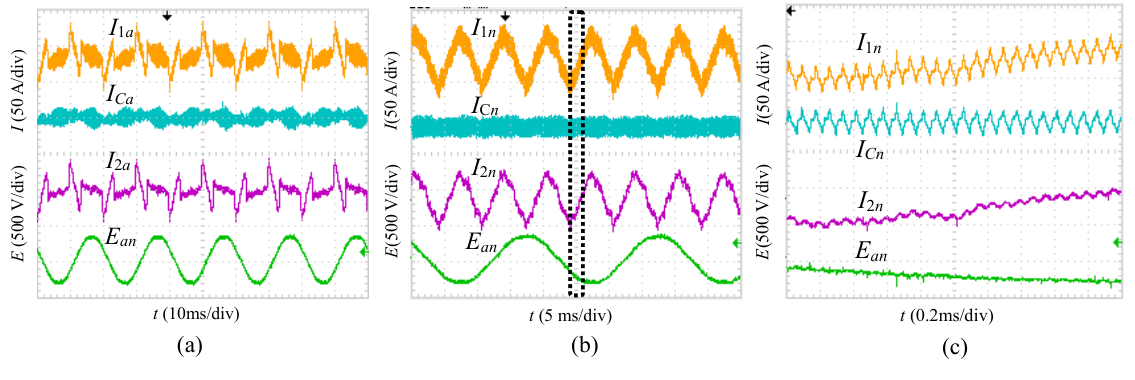
Figure 15. Waveforms of the 4B-LCL ( a ) in phase A ( b ) in phase N ( c ) Zoomed-in